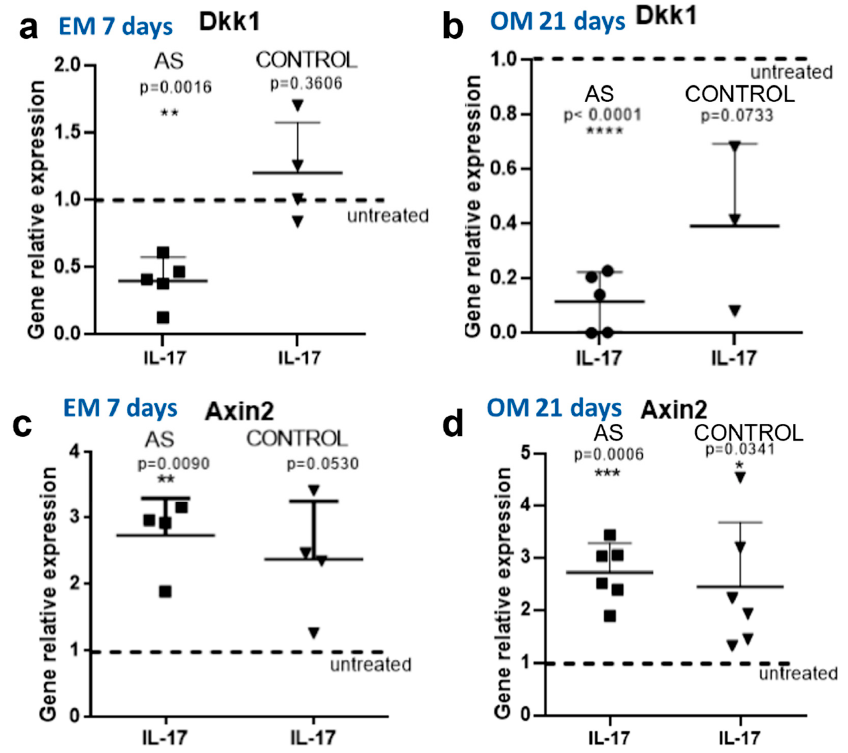
Figure 3. Effect of IL-17 on DKK1 expression and WNT pathway activation. DKK1 and Axin2 ex- pression levels in the control group and AS group were determined by the quantitative RT-PCR method. ( a ) DKK1 relative expression following cell culture in expansion medium in the presence (IL-17) or absence (UT) of 50 ng/mL IL-17 for 7 days (EM 7 days) and ( b ) in osteogenic medium in the presence (IL-17) or absence (UT) of 50 ng/mL IL-17 for 21 days (OM 21 days). ( c ) Wnt activation marker Axin2 expression levels following cell culture in expansion medium in the presence (IL-17) or absence (UT) of 50 ng/mL IL-17 for 7 days (EM 7 days) and ( d ) in osteogenic medium in the presence (IL-17) or absence (UT) of 50 ng/mL IL-17 for 21 days (OM 21 days). All graphs indicate mean ± SD. Each assay is expressed as fraction of the UT expression normalized to unity. * = p < 0.05; ** = p < 0.01; *** = p < 0.001; **** = p <